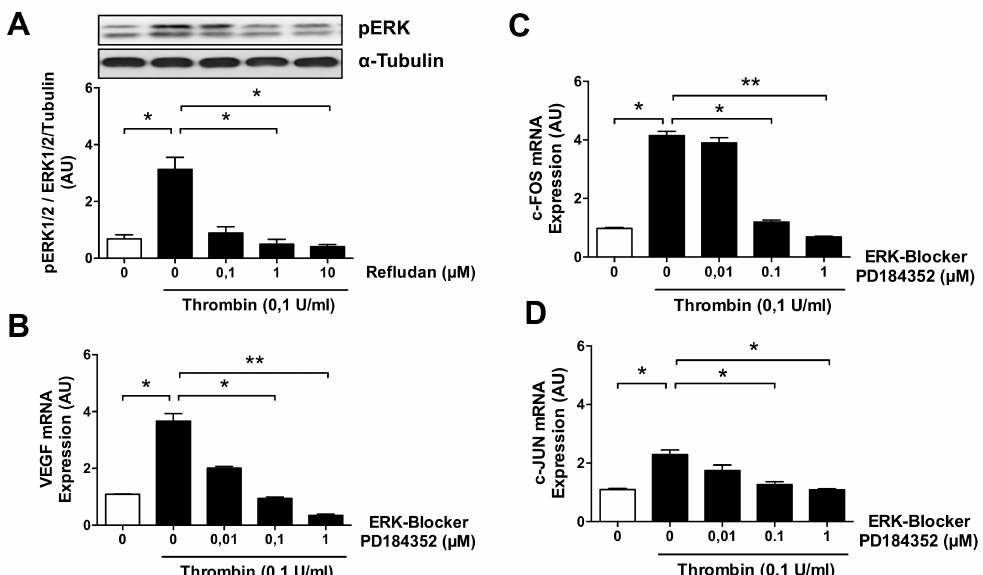
Figure 5. ERK1/2 and AP-1/c-FOS/c-JUN mediate thrombin stimulation in microvascular ECs. ( A ) HMECs were pretreated for 1 h with or without the thrombin inhibitor Refludan and then stimulated with thrombin (0.1 U/mL) for 15 min and assessed for the presence of phosphorylated ERK1/2 ( n = 5). ( B – D ) HMECs were pretreated for 1 h with or without the ERK inhibitor PD-184352 and then stimulated with thrombin (0.1 U/mL) for 1 h, after which the levels of ( B ) VEGF mRNA and ( C ) FOS mRNA and (D) JUN mRNA were measured ( n = 4). ANOVA mean +/ − SEM with * p < 0.05 and ** p <